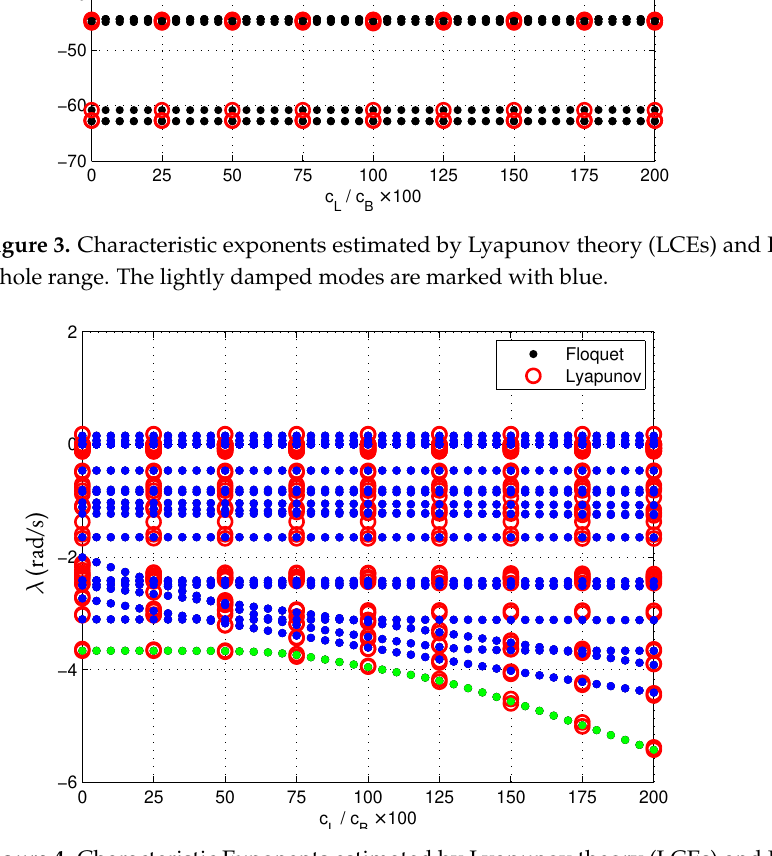
Figure 4. Characteristic Exponents estimated by Lyapunov theory (LCEs) and Floquet multipliers, zoom of lightly damped modes from Figure 3. The lightly damped blade lead-lag mode is marked in